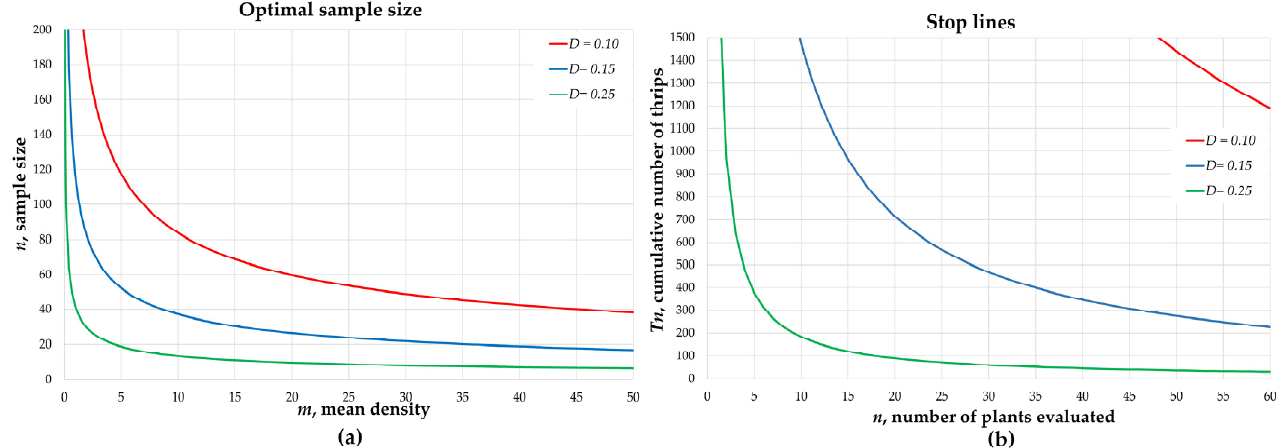
Figure 2. Sequential sampling with three levels of precision. ( a ) Relationship between the optimal sample size and the average density and ( b ) sampling stop lines based on accumulated counts.